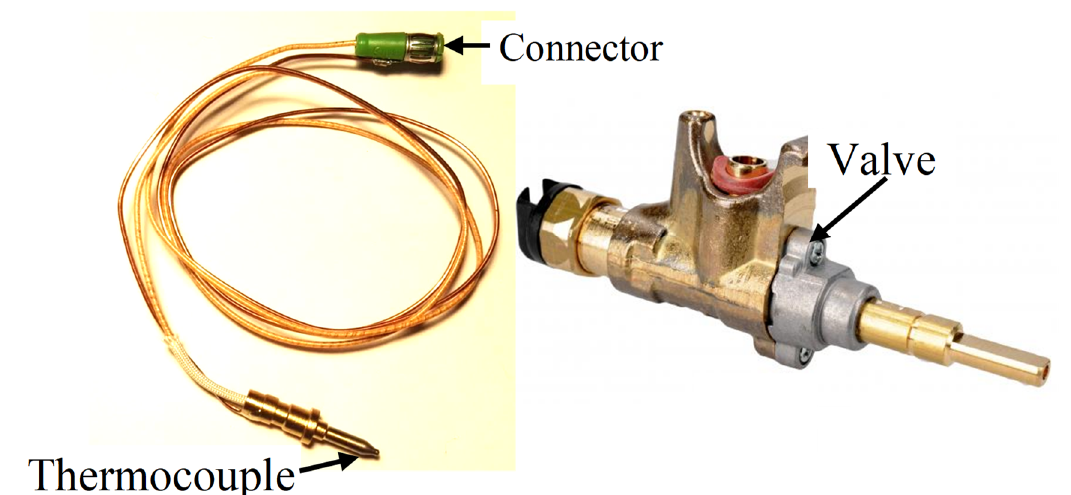
Figure 1. The gas electromagnet valve with the thermocouple